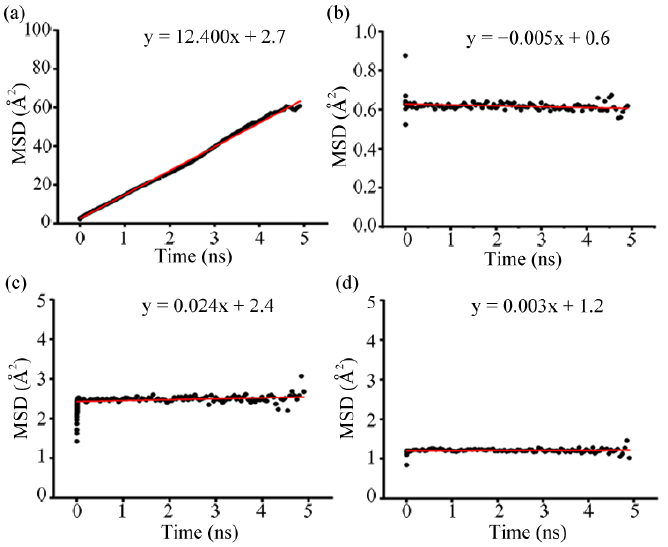
Figure 7. Mean square displacements for ( a ) F 2 , ( b ) Cl 2 , ( c ) H 2 S, and ( d ) SO 2 in CALF-20 during 5 ns of MD simulations.